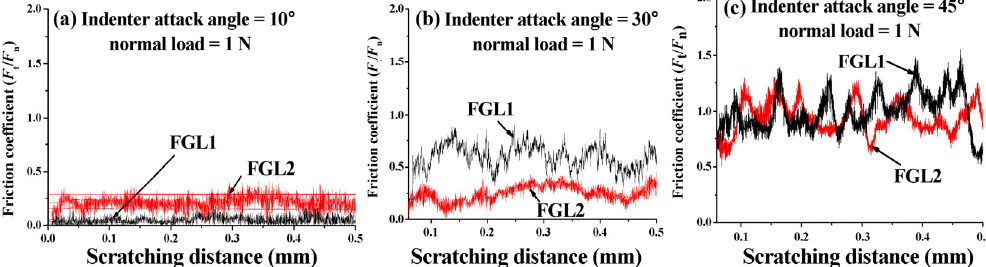
Fig. 9 Friction coefficient vs. scratching distance and indenter attack angle (normal load = 1 N).